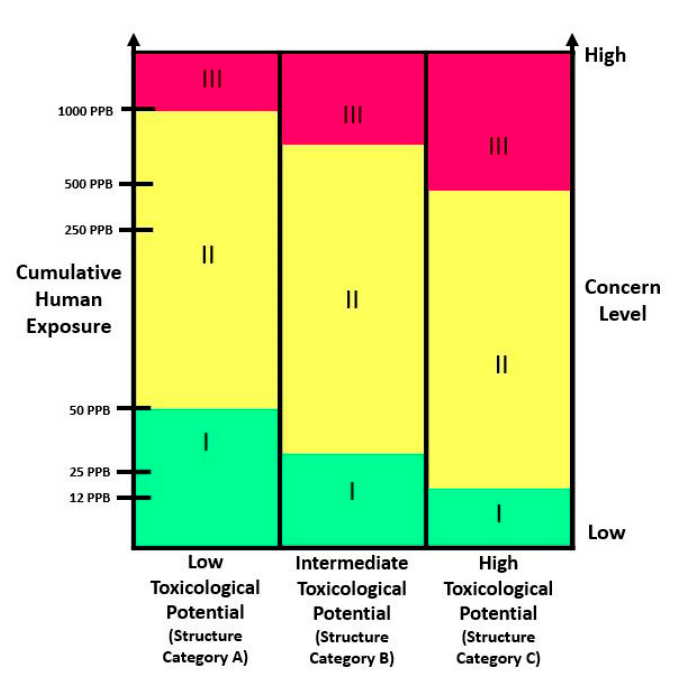
Figure 3. Concern level (CL) defined according to the human exposure and chemical structure. The cumulative human exposure is expressed as ppb of daily dietary consumption of food additive. Adapted from: Redbook [93].